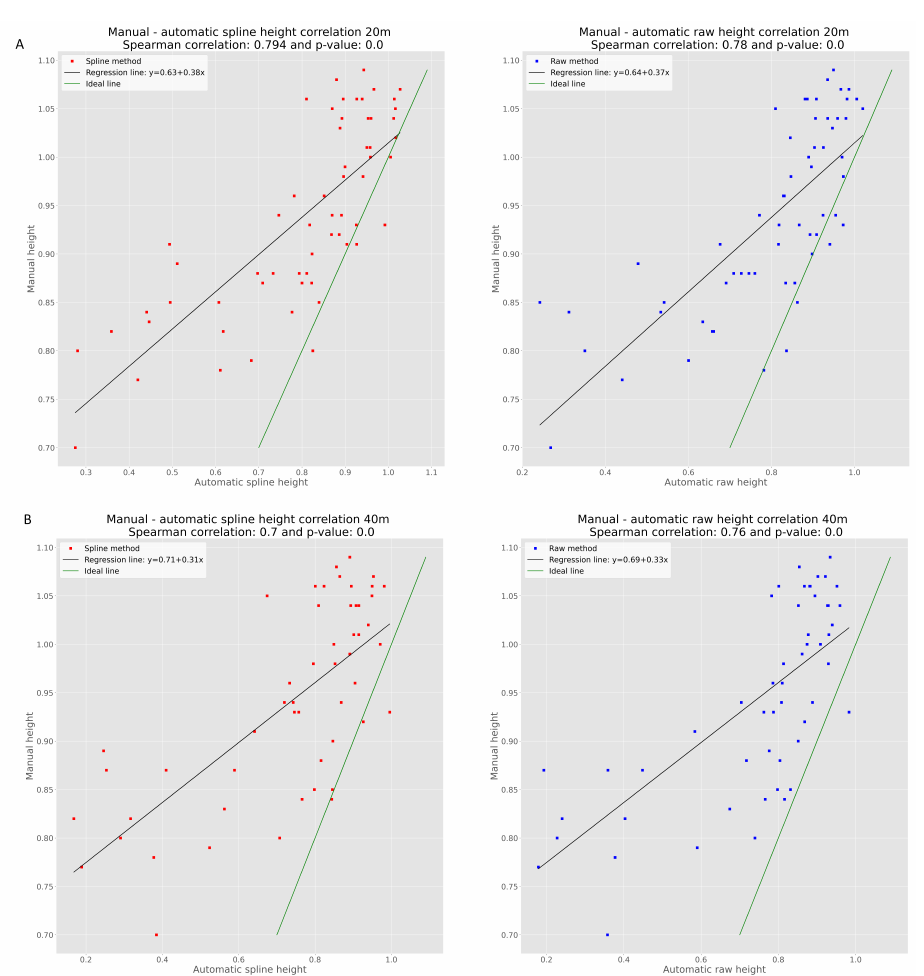
Figure 10. Correlation plots of manual measure of plant height with “spline” and “raw methods of automatic plant height estimation” for two UAV flight levels. ( A ) 20 m AGL; ( B ) 40 m